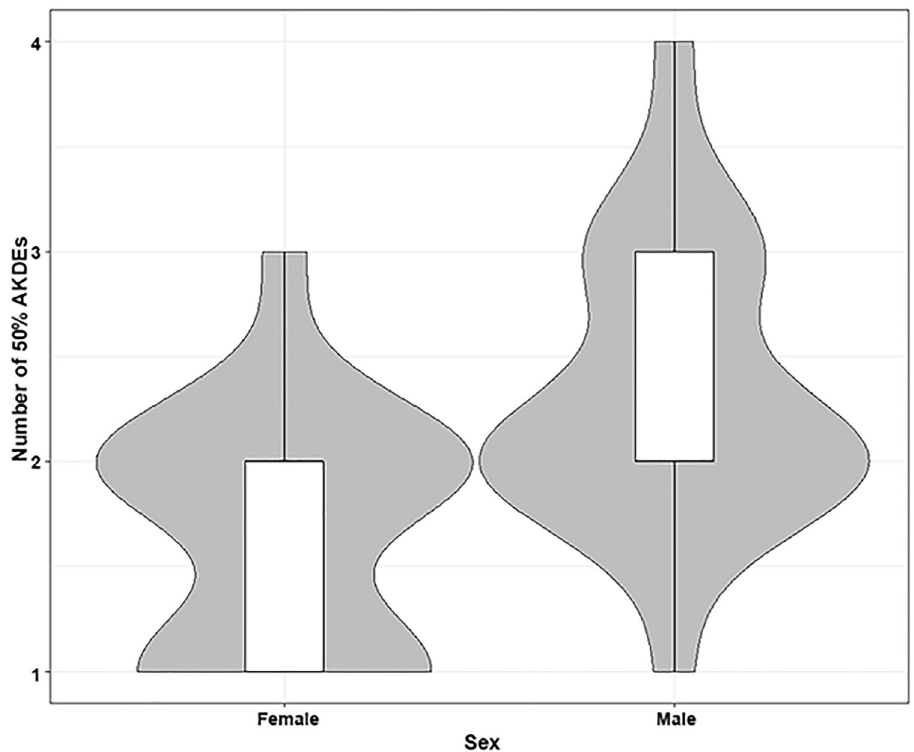
Figure 5. Count of core regions described by the autocorrelated kernel density estimate (number of 50% AKDEs) of female and male badgers. The upper and lower quartiles (mean point between maximum/minimum data points and the median) are shown at the top/bottom of the bar. Whiskers (vertical black lines) denote lower and upper 25% of data values. The density distribution of data is shown with grey